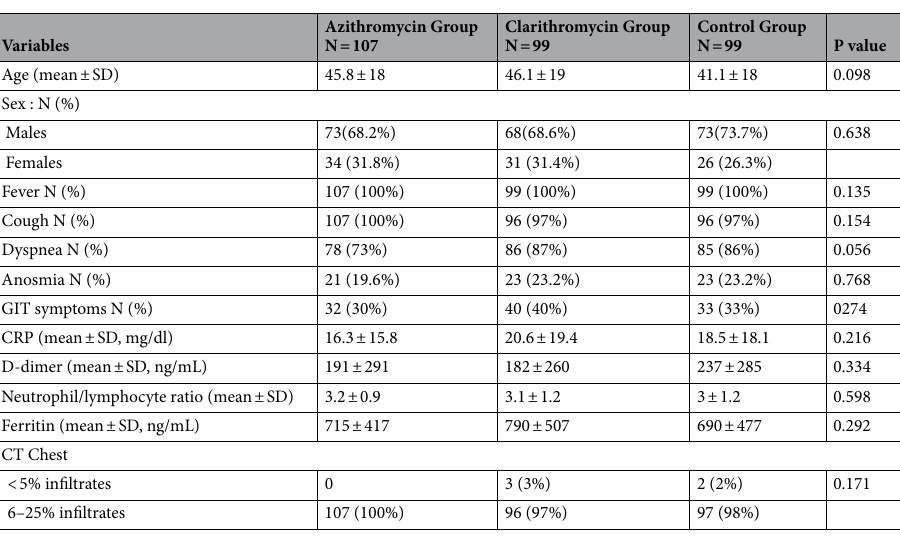
Table 1. Baseline characteristics of the study